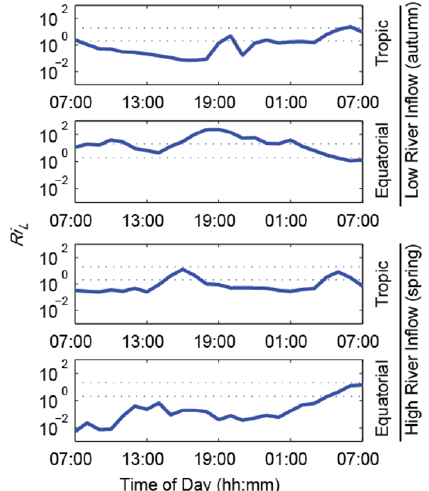
Figure 9. Layer Richardson numbers ( Ri L ) during each of the tidal cycle surveys at Cocodrie. The dotted lines ( Ri L equal 2 and 20) indicate the upper limit for complete mixing and lower limit for full stratification, respectively. Between these limits water column stability is transitional.